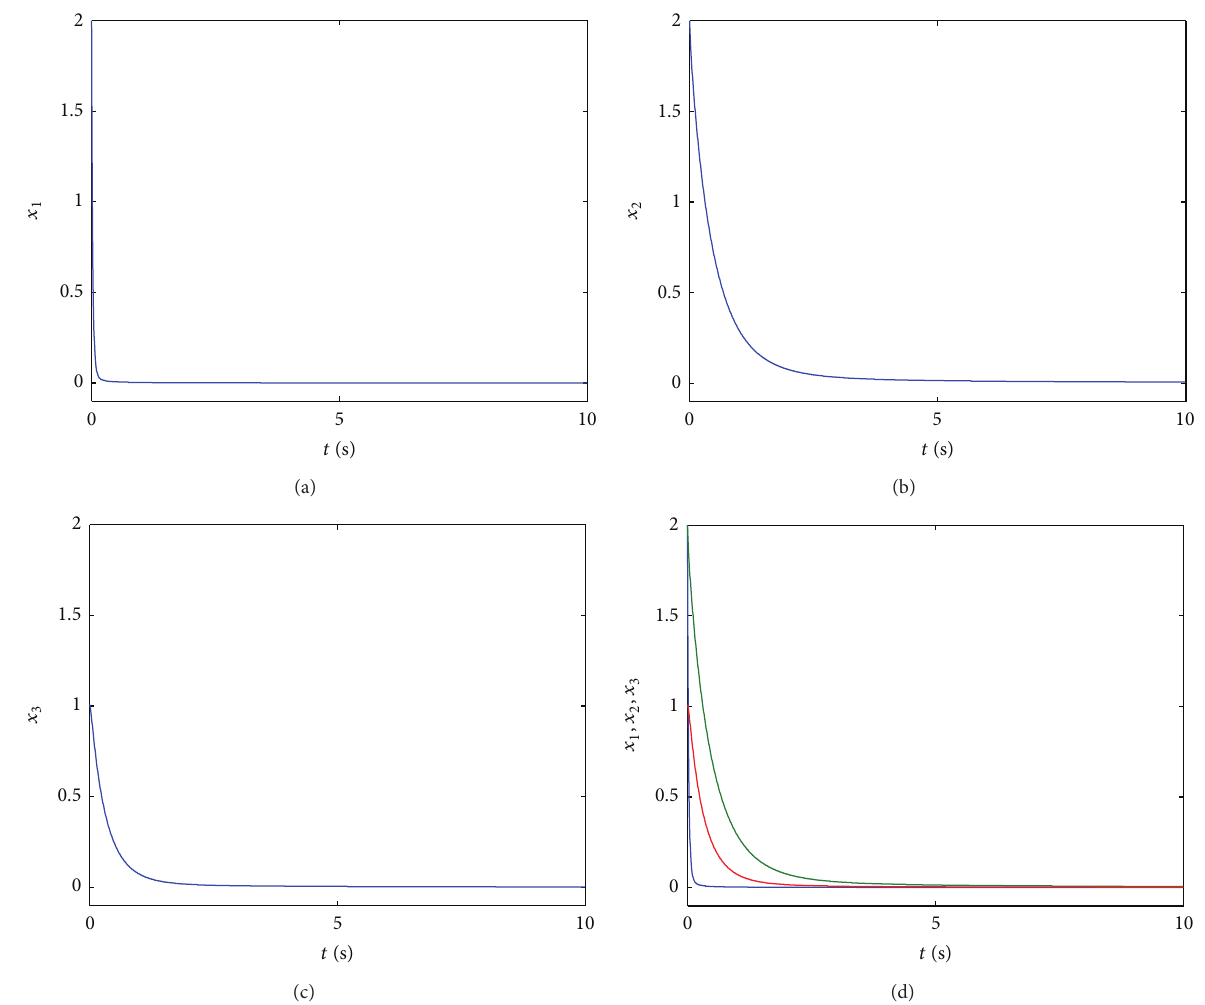
Figure 2: Time waveforms of state variables 𝑥 1 (𝑎) , 𝑥 2 (𝑏) , and 𝑥 3 (𝑐) of the controlled fractional order Chen system. system, fractional order Chen system, fractional order